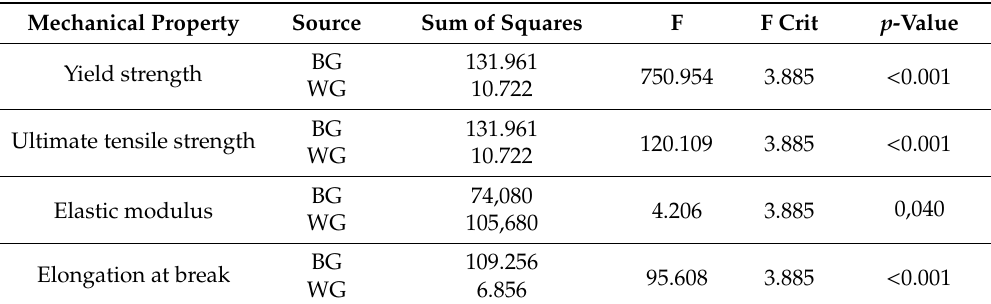
Table 2. ANOVA tests for tensile properties.